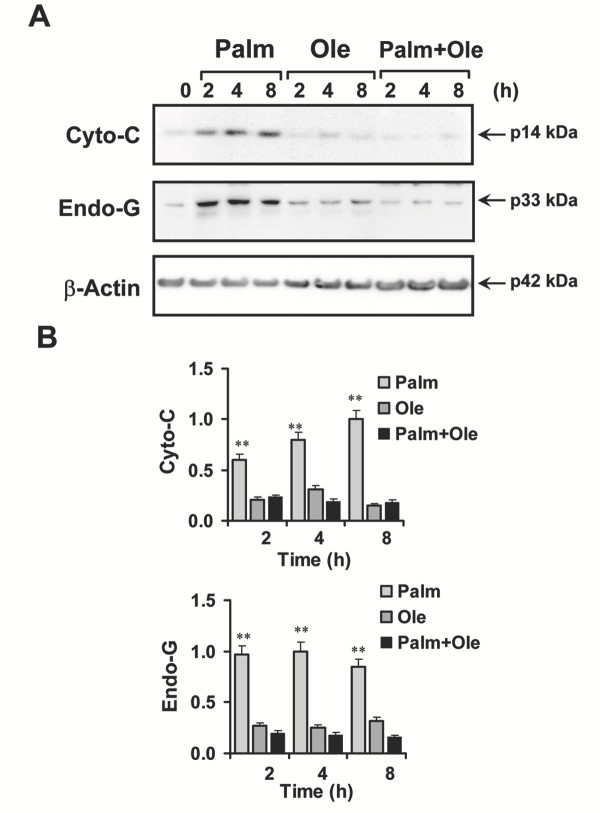
Oleate prevents mitochondrial release of cytochrome-c and endonuclease G in cell treated with palmitate. (A) HMC were incubated with 0.2 mM palmitate (Palm), 0.2 mM oleate (Ole), or palmitate plus oleate for the times indicated. The cells were fractionated and the levels of cytoplasmic p14 kDa cytochrome-c (Cyto-c) or p33 kDa endonuclease G (Endo-G) protein were measured by Western blotting. Equivalent amounts of protein were added to each lane, as confirmed by reprobing with β-actin. (B) Densitometry of cytoplasmic p14 kDa cytochrome-c and p33 kDa endonuclease G protein from 3 independent experiments. **, P < 0.01, *, P < 0.05 by ANOVA versus 0 time.